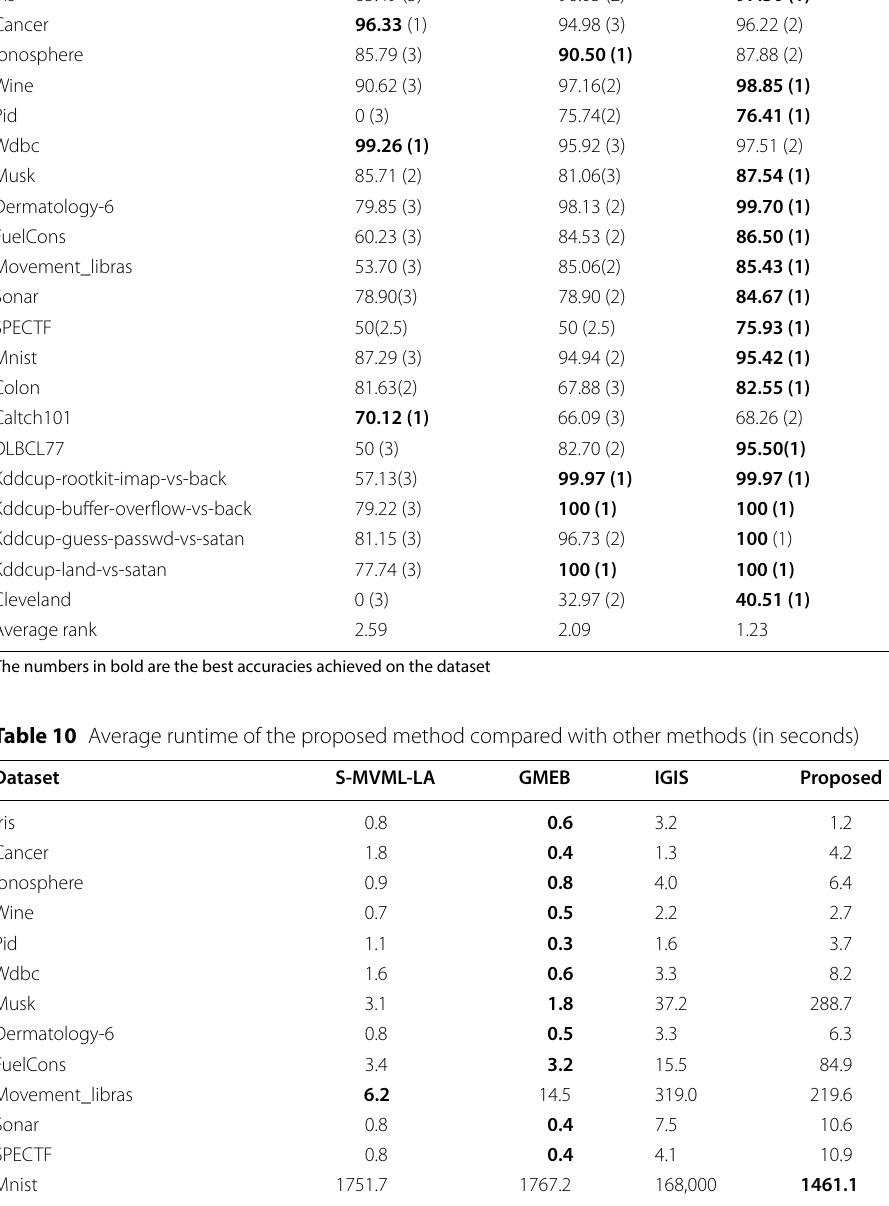
Table 9 The proposed cost-sensitive method with other methods in term of G.Mean Dataset